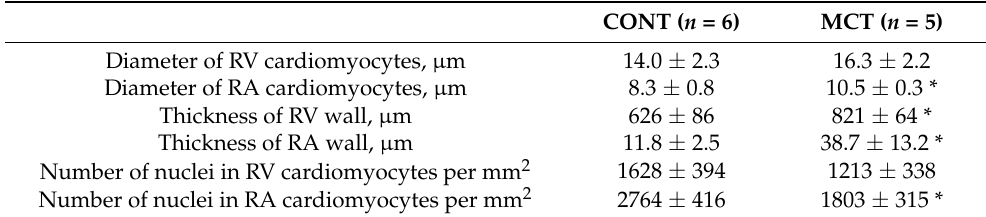
Table 2. Morphometric features of right ventricular (RV) and right atrial (RA) tissue of control rats (CONT) and rats with the experimental model of pulmonary hypertension (MCT).